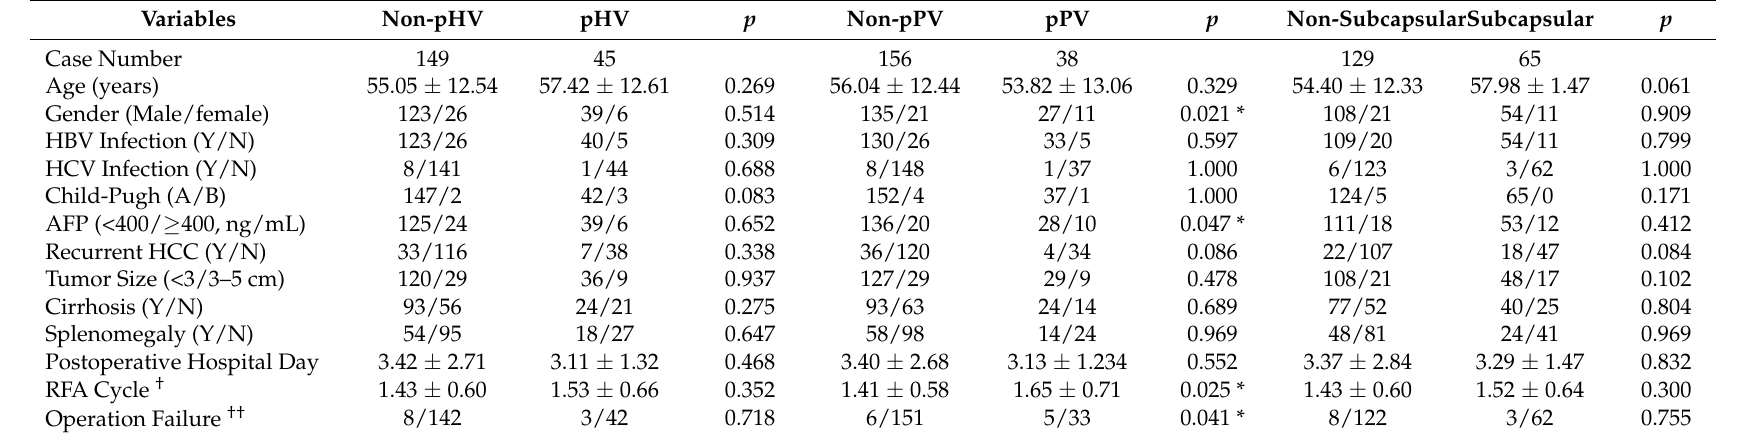
Table 1. Baseline